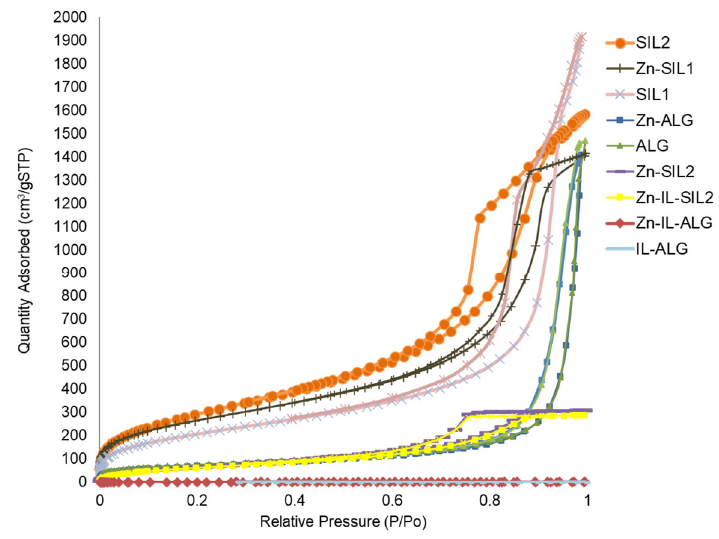
Figure 5. Nitrogen adsorption isotherms of the alginate and silica aerogels.